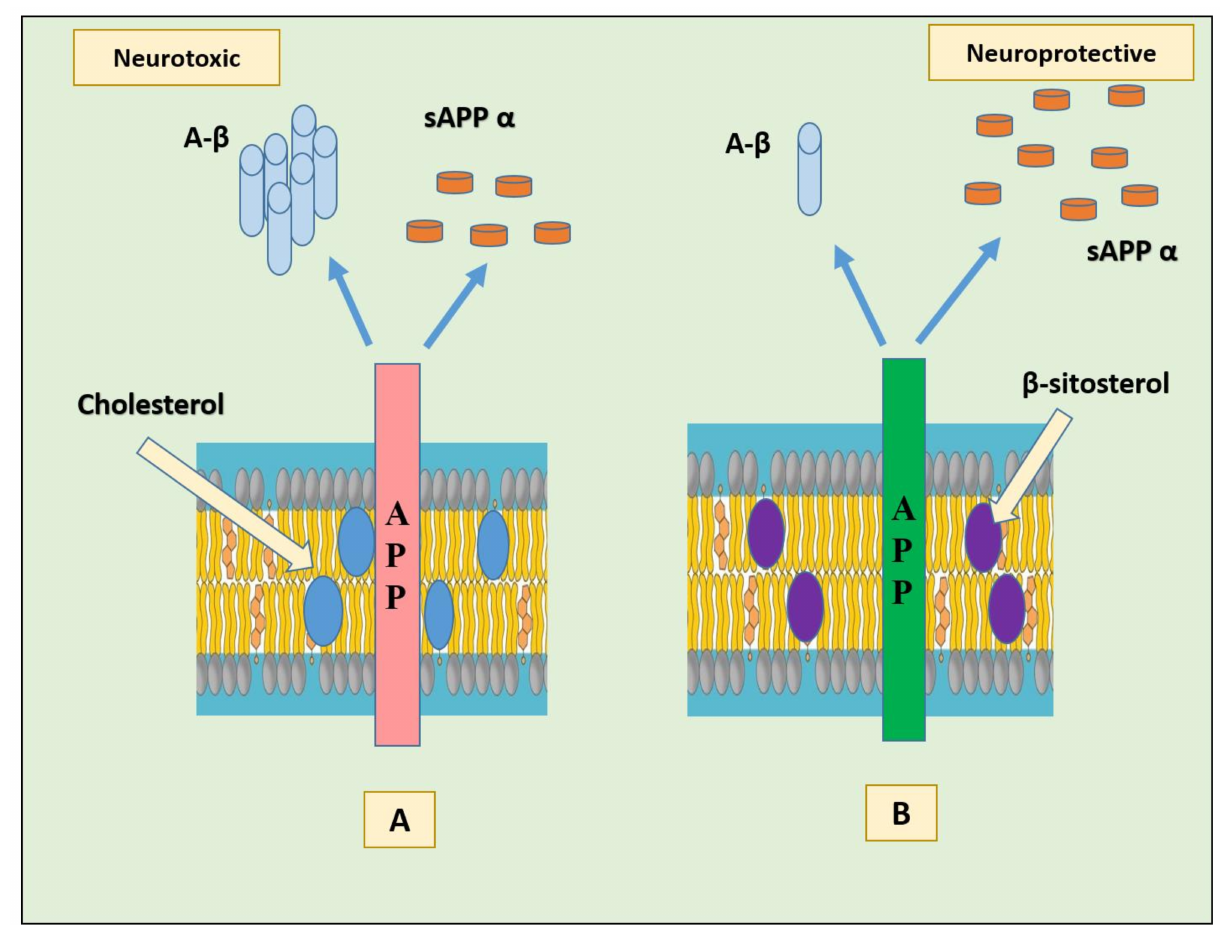
Figure 3. ( A ) Membrane cholesterol favors β -secretase cleavage of APP by direct binding to the C-terminal transmembrane domain of APP, generating neurotoxic A β and less sAPP α . ( B ) Substitution of membrane cholesterol with β -sitosterol promotes the re-distribution of APP in non-raft region and non-amyloidogenic processing, generating less A β and more of neuroprotective sAPP α . Abbreviations: A β : beta amyloid; APP: amyloid precursor protein; sAPP α : soluble alpha-amyloid precursor